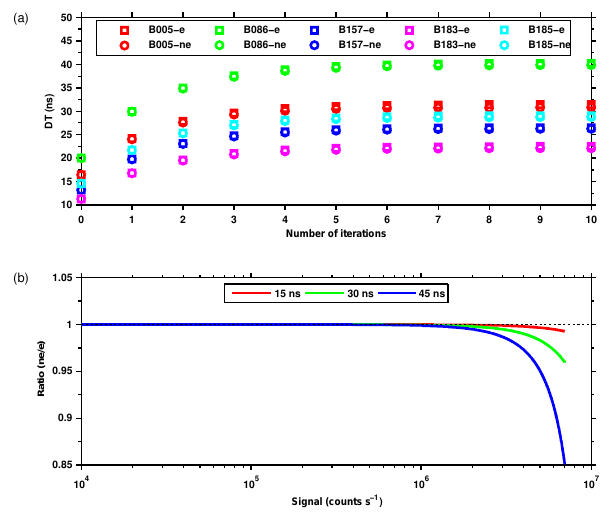
Figure 1. (a) Dead time derived with the extended (e) and the non- extended (ne) approach for five Brewers with DT ranging from 19 to 42ns as a function of the number of iterations. (b) Ratio between signals corrected using the non-extended and the extended approach as a function of the logarithm of the measured, uncorrected for the dead time, signal (in countss − 1 ) , for three different values of